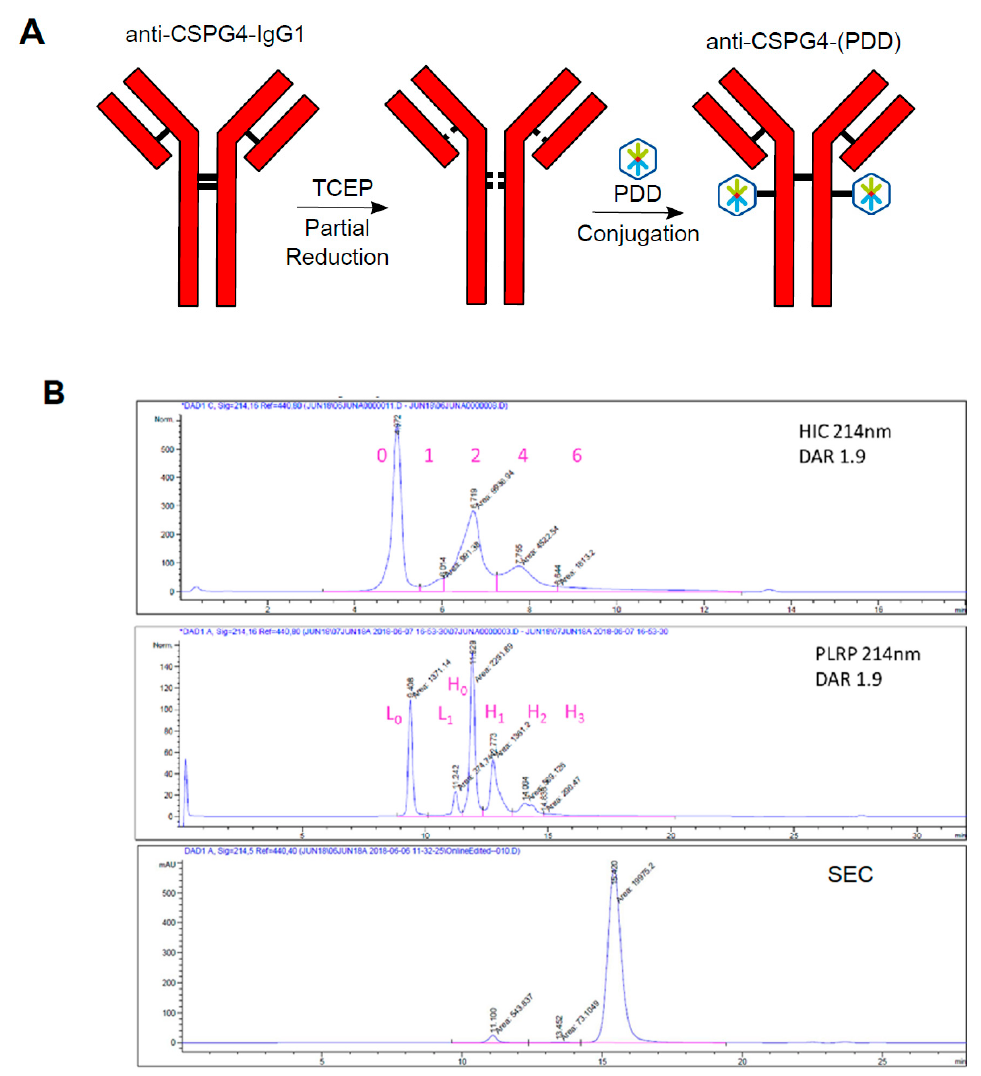
Figure 4. Conjugation of anti-CSPG4-IgG1 antibody to PDD payload via stochastic conjugation generates anti-CSPG4-(PDD) ADC with a drug antibody ratio (DAR) of 1.9. ( A ) Schematic diagram of stochastic ADC conjugation by antibody reduction with TCEP, followed by partial oxidation with DHAA and then conjugation to PDD via a Val-Ala-maleimide linker; ( B ) Analytical data from the stochastic conjugation of the anti-CSPG4-IgG1 antibody to the PDD. The HIC (top panel) and PLRP (middle panel) analyses confirm an average drug-antibody ratio (DAR) of 1.9, and the Size Exclusion Chromatography (SEC) trace (bottom panel) indicates negligible aggregation of the ADC and no detection of free linker-payload.